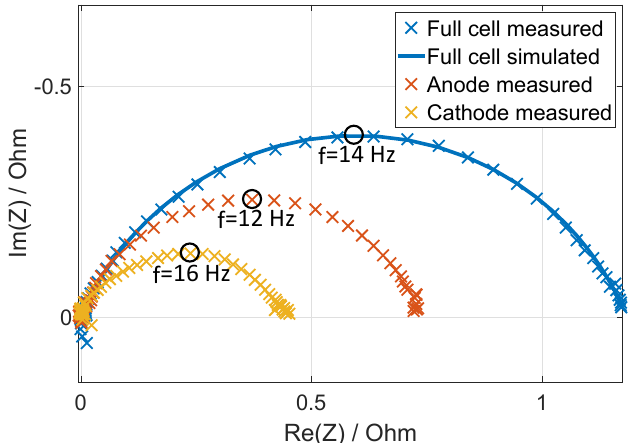
Figure 1. Nyquist plot of the impedance of cell I (60 mAh Li-ion pouch cell) with the correspond- ing half-cell impedances. Inductive and diffusive parts have been omitted. Measurements were conducted at room temperature and SOC 50 for the full